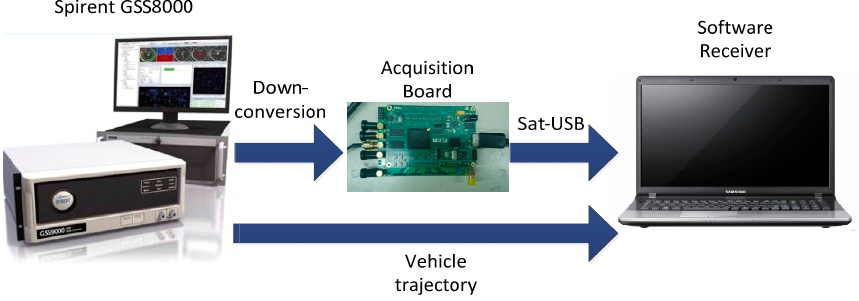
Figure 16. Hardware simulation testing platform.